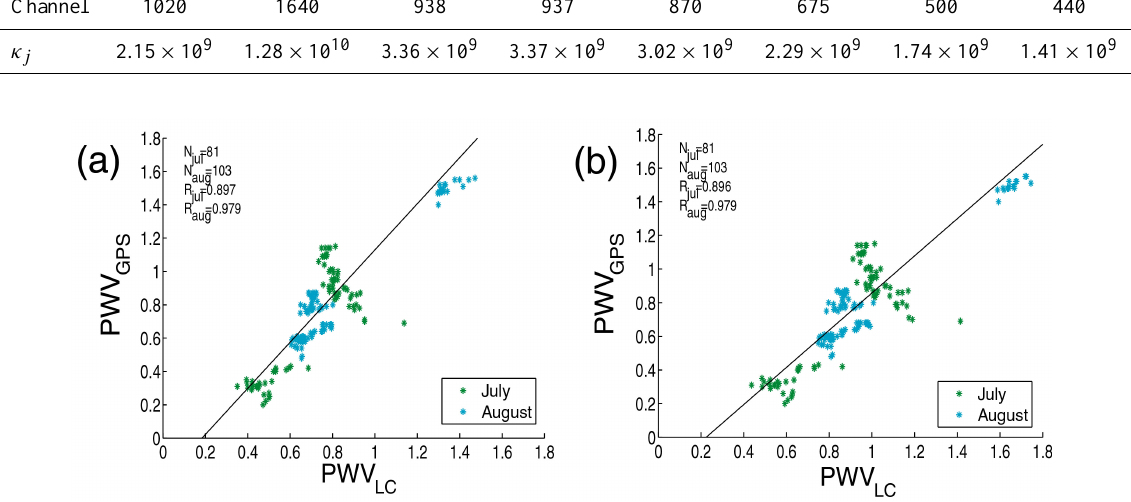
Fig. 3 : PWV-GPS (cm) from ultra-rapid orbits versus PWV-LC (cm) for channels centered at (a) 937 nm (Filter#2) and (b) 938 nm (Filter#1). The number of pairs as well as the correlation coefficient ( R ) for each month have been included. Solid line represents the linear regression line. Table 3. Mean, standard deviation σ and RMSE (cm) of the PWV difference (photometer minus GPS data) obtained from the compar- ison study between diurnal CA, nocturnal LC and GPS (ultra-rapid orbits).